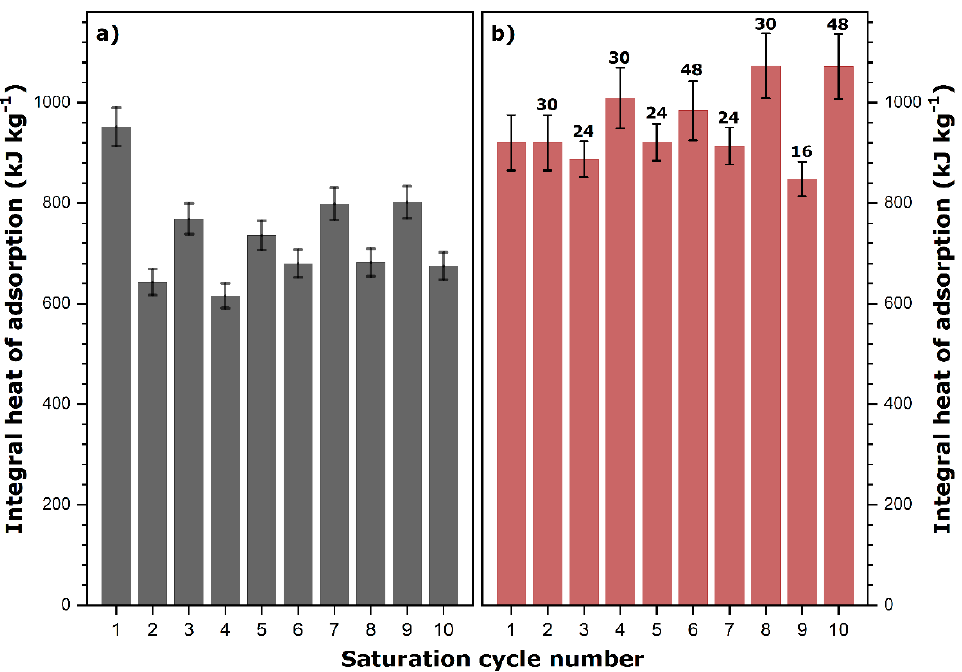
Figure 3. Integral heat of adsorption released during 10 consecutive saturation cycles for Na-13X ( a ) and PBA ( b ) studied after a regeneration stage performed by a flow of helium at 353 K; prior to the first saturation cycle, the adsorbent was activated by a vacuum treatment at 353 K for 48 h; error bars represent the measurement uncertainty. Since a somewhat different operating procedure was followed for PBA, the dehydration time applied before a given saturation cycle is marked by a number on top of each bar.